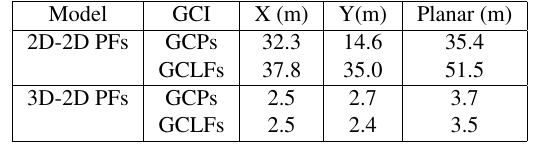
Table 1: The CPs RMSE using 1st order 2D-2D and 3D-2D PFs for the two different forms of GCI (GCPs and